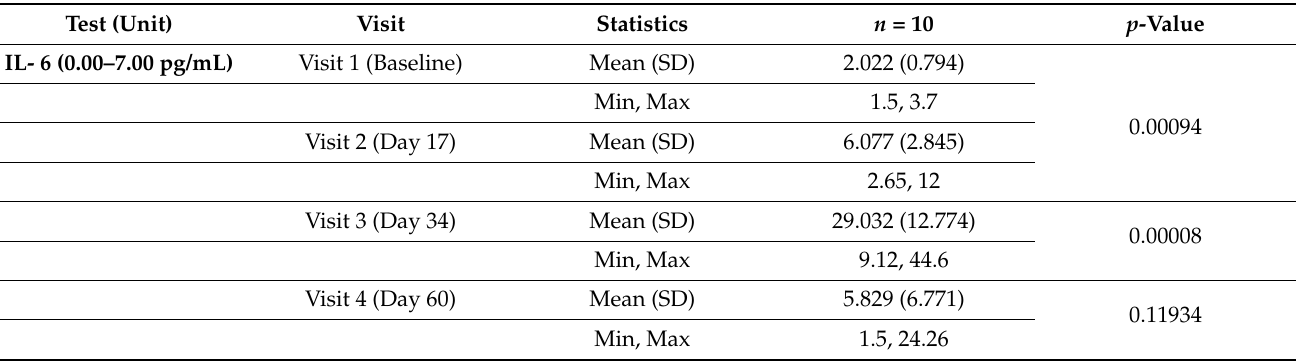
(Table 4). Individual supporting data presented in Supplementary Materials. Table 3. IL- 6 (0.00–7.00 pg/mL) changes after treatment in comparison with baseline, (RM- ANOVA test).